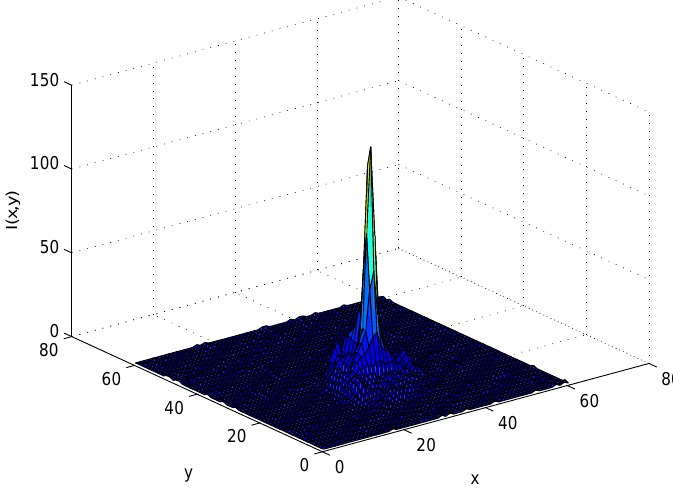
Figure 1. IRED image taken by the camera represented as a 3-D